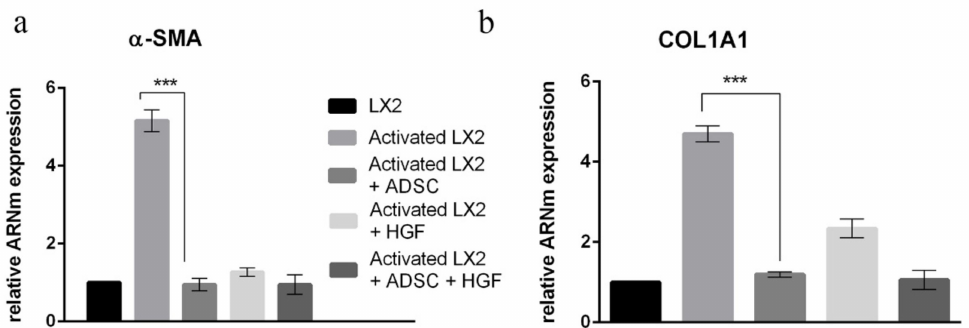
Figure 5. Evaluation of α -SMA ( a ) and COL1A1 ( b ) expression in HSCs by qPCR. Statistical signifi- cance: *** p <